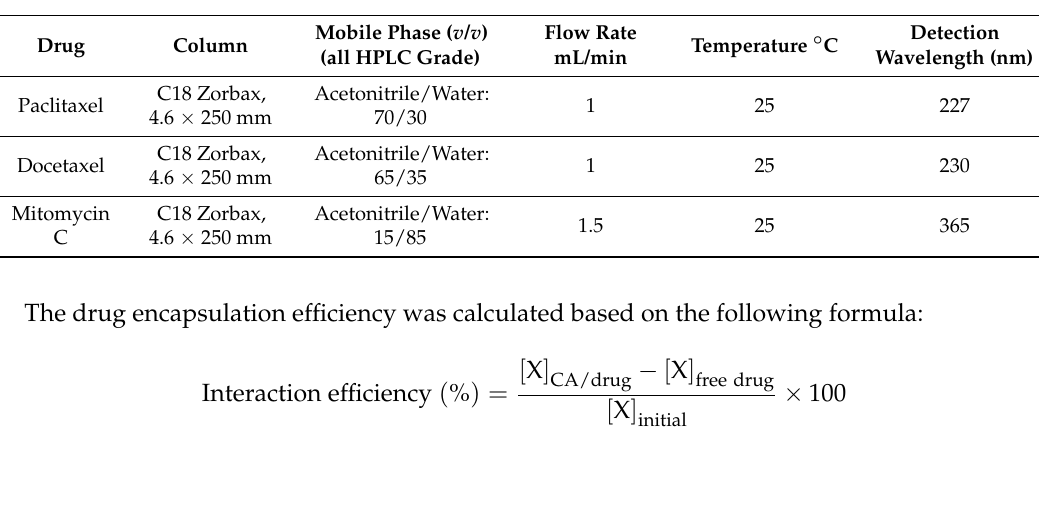
Table 1. The drug encapsulation efficiency of carbonate apatite nanoparticles formulated as mentioned earlier by applying 7 mM calcium and 100 µ M of each